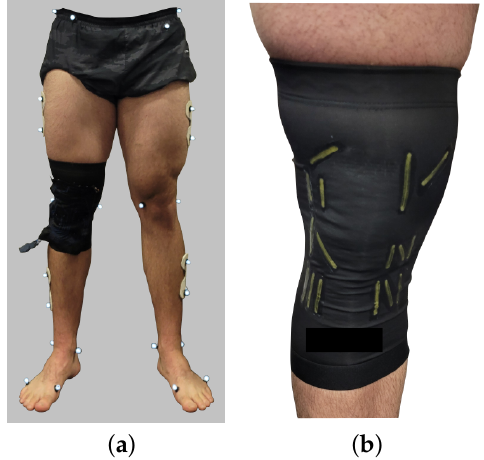
Figure 2. ( a ) shows the placement of the instrumented knee sleeve and markers used in the data collection portion of the study. The placement of 16 sensors within the knee sleeve are shown in yellow in ( b ). ( a ) Marker/sleeve placement. ( b ) Sensor